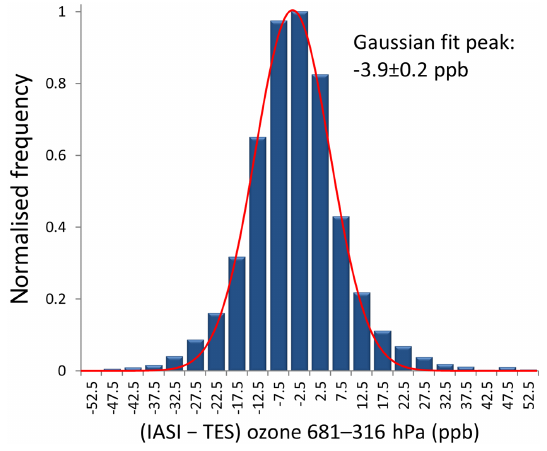
Figure 3. Normalised frequency distribution of the offset of the data of Fig. 2. The distribution of the difference between TES and IASI-TOE follows roughly a Gaussian function with the maximum at ( − 3.9 ± 0.2)ppb.